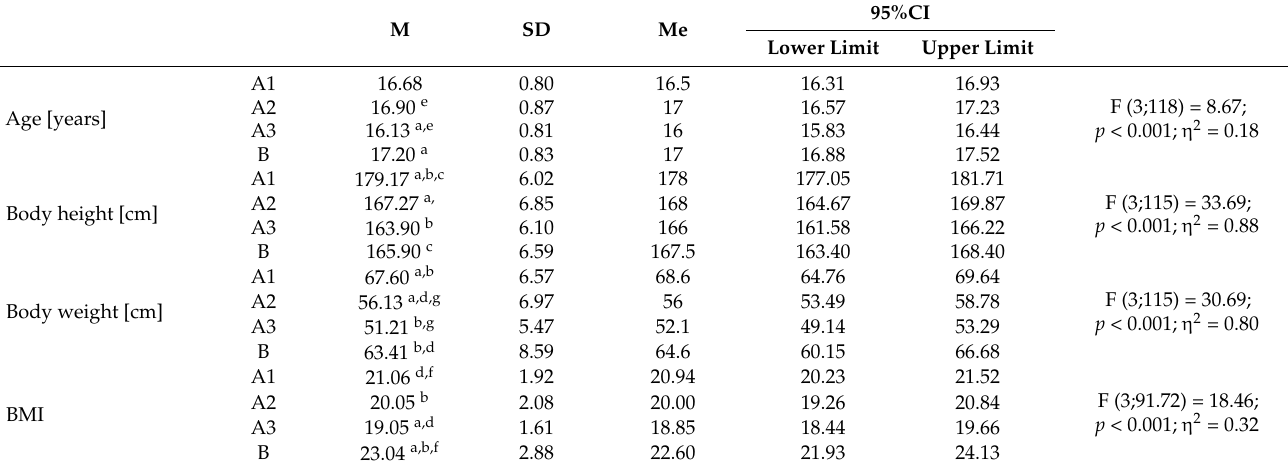
Table 1. Age, height, weight, and BMI of female athletes (A1, A2, A3) and girls from the control group (B).